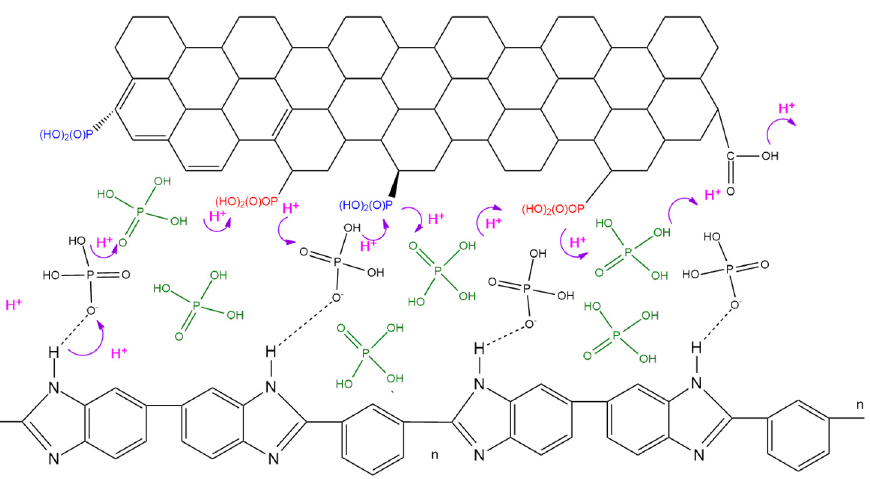
Figure 11. Schematic diagram on the proposed Grotthus mechanism of proton transfer between PA-doped PBI and PGO.